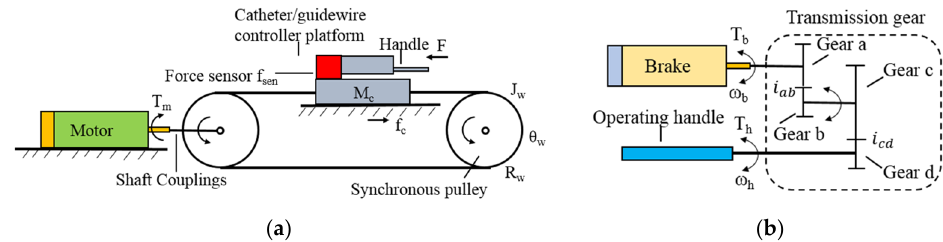
Figure 5. Schematic of force feedback structure. ( a ) Linear force feedback control mechanism. ( b ) Rotation torque feedback control mechanism.